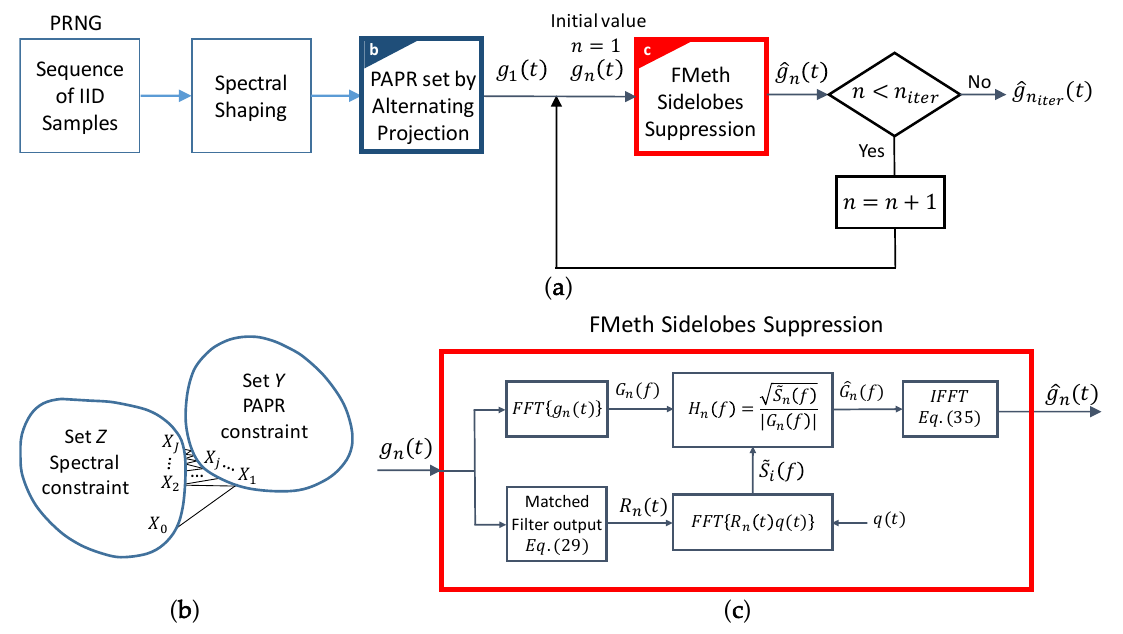
Figure 17. ( a ) Functional block diagram of the generation of a noise waveform. ( b ) The “Alternating Figure 17. (a) Functional block diagram of the generation of a noise waveform. (b) The “Alternating Projection” method. ( c ) Functional block diagram of the FMeth algorithm to suppress the Projection” method. (c) Functional block diagram of the FMeth algorithm to suppress the sidelobes.